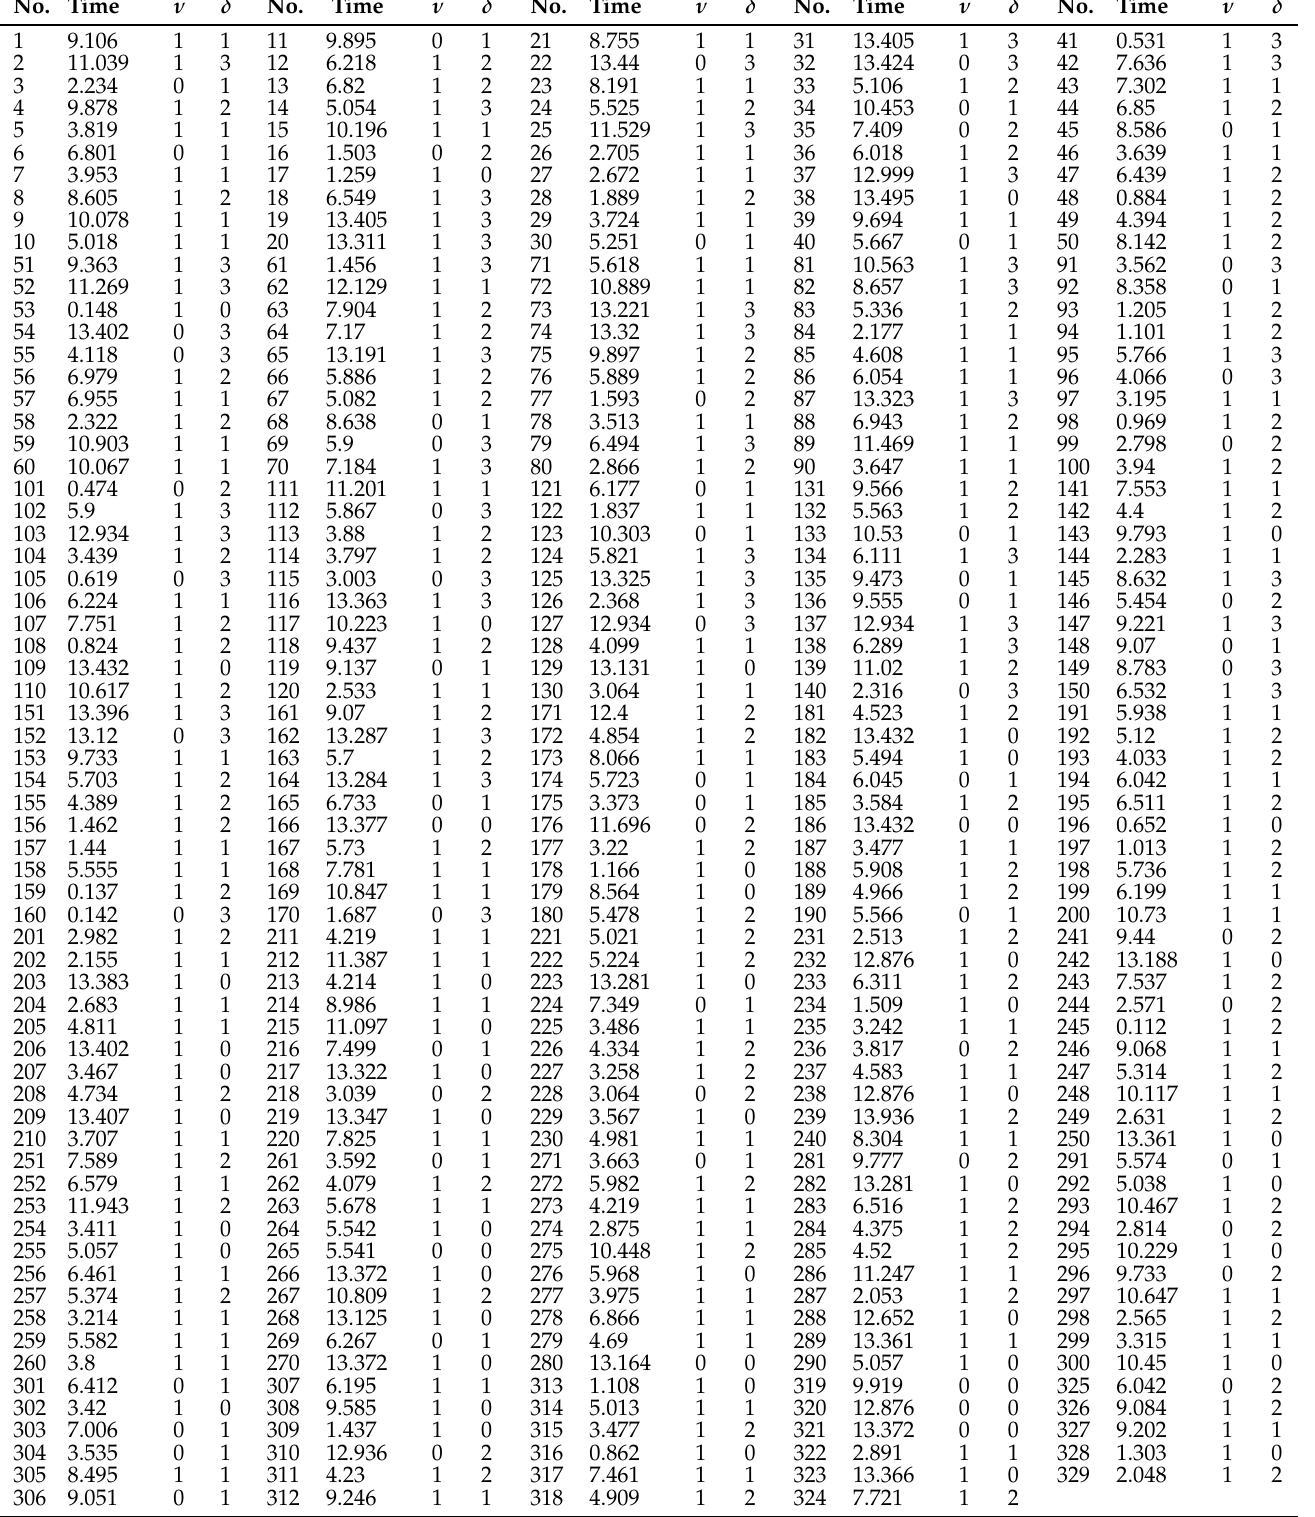
Table 7. Left-truncated and right-censored HIV infection competing risks